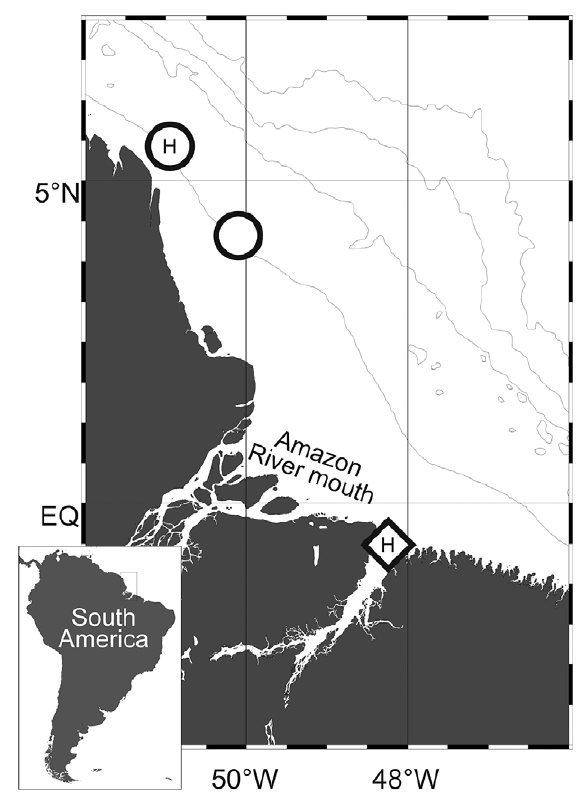
Fig. 1. – Sample sites for Eutima marajoara n. sp. (circles) and Hel- gicirrha angelicae n. sp. (diamond) along the Amazonian coast. “H” indicates holotype